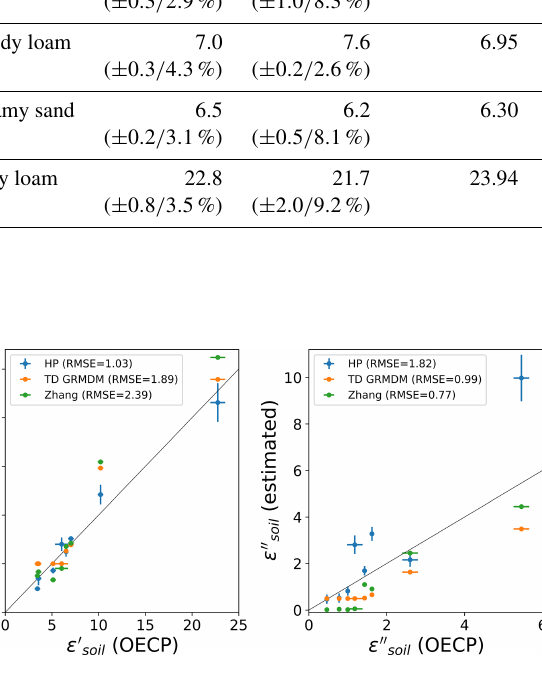
Figure 9. OECP real ( ε (cid:48) ) and imaginary ( ε (cid:48)(cid:48) ) permittivity compared to HP (instrument), TD GRMDM (model) and Zhang (model) with the OECP as the reference. The black line is the 1 : 1 reference ratio and the root mean square error (RMSE) is given in